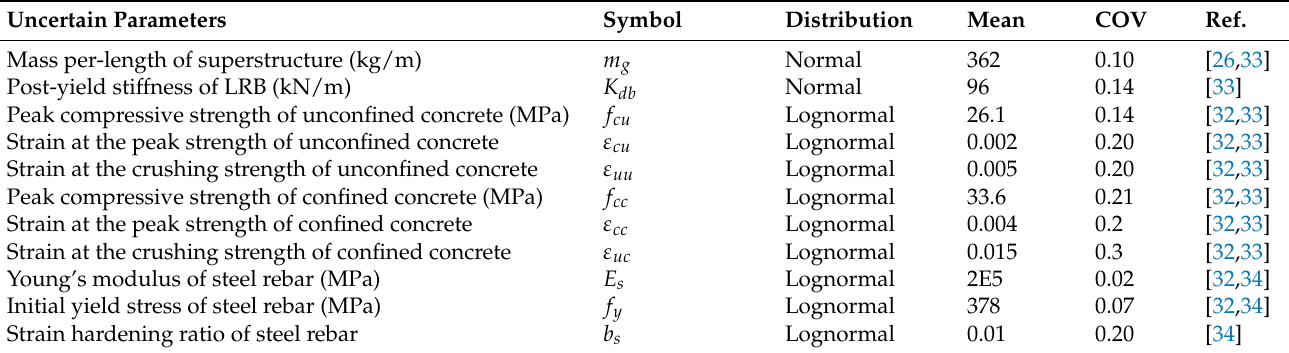
Table 1. Statistical information of the uncertain